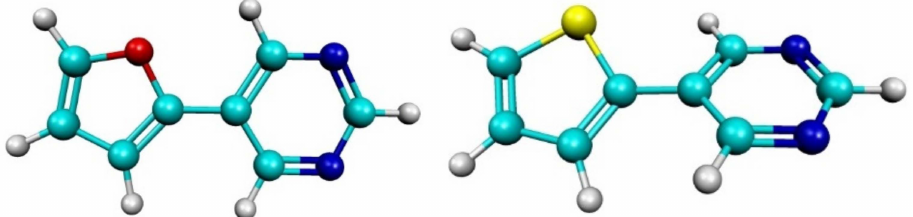
Figure 7. Optimized molecular structures of PrmF (left) and PrmT (right).